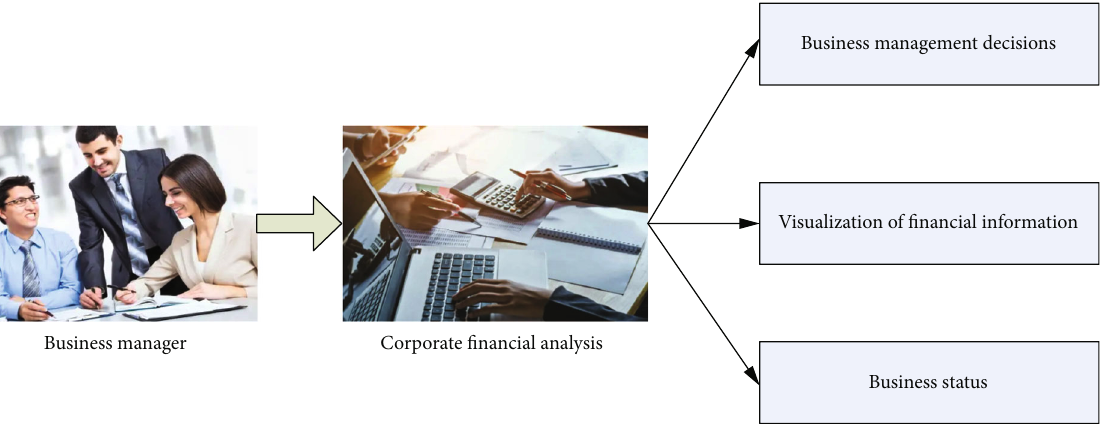
Figure 1: Process diagram of enterprise fi nancial analysis.